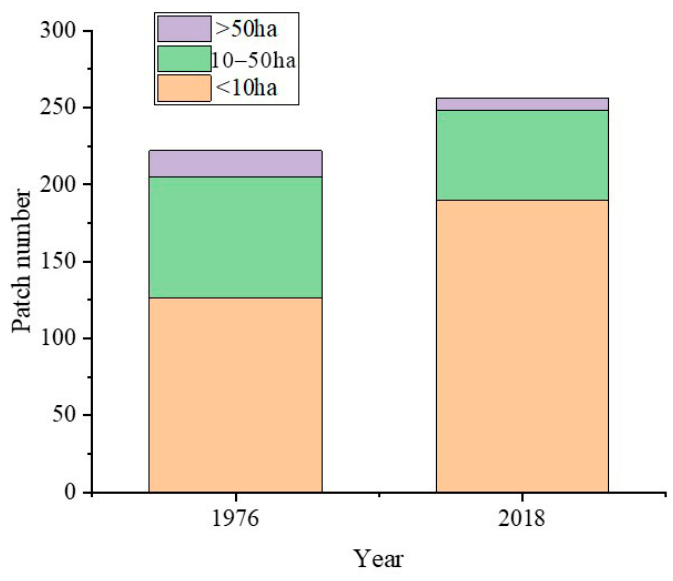
Figure 6. The number of historical forest patches. Table 3. The temporal changes in transformed area (ha).